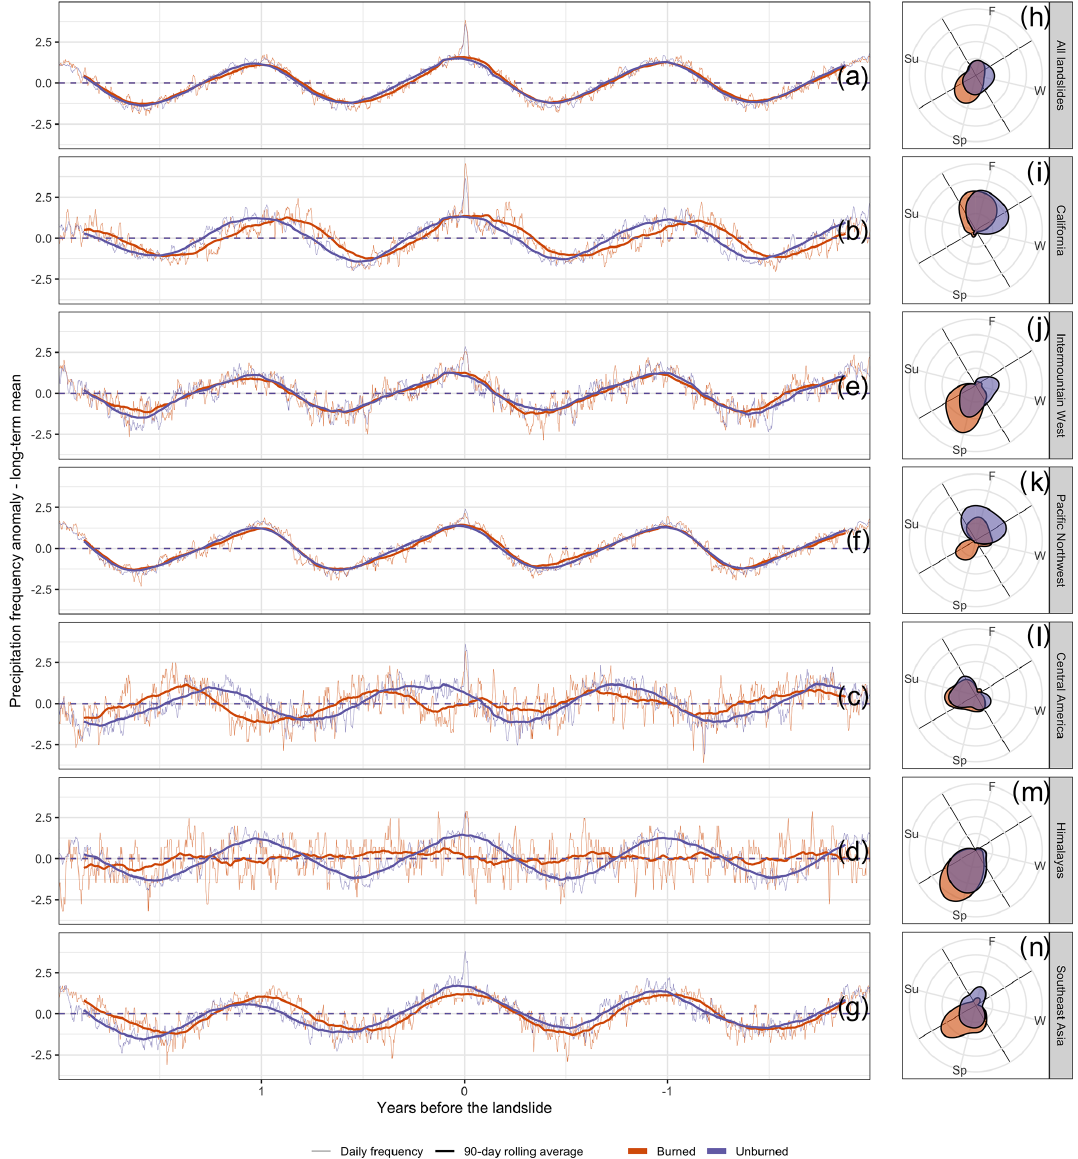
Figure 9. Precipitation frequency anomaly relative to the long-term mean aligned by the mass movement date. (a, g) Frequency is shown both daily and smoothed with a 90d moving average to highlight shifts. Daily precipitation frequency is represented as thin lines in orange and purple (burned and unburned groups), while the 90d average is a thicker line. The long-term mean has been removed from all the frequency curves. Landslides are in burned and unburned groups for each region separately and for all mass movements. (h–n) The kernel density estimate of mass movements by the time of year is shown for both the burned and the unburned groups in a radial